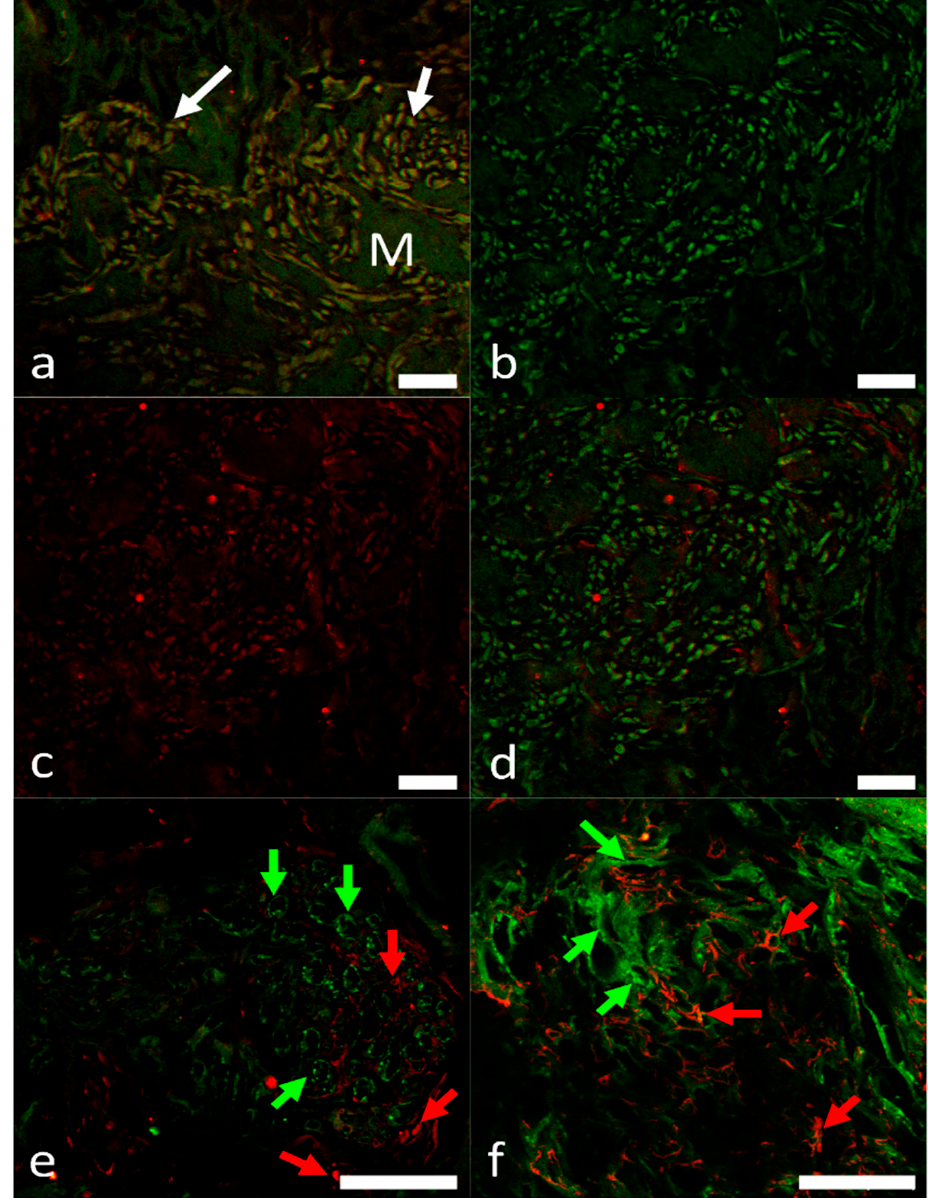
Figure 6. Multiple clusters of pacemaker cells detected by the double immunolabeling with antibodies against Islet-1 (green signal), and HCN1 and HCN2 (red signal) in the SAR. ( a ) Pacemaker cells (arrows) embedded in the myocardium (M) expressing Islet-1 (green signal) and HCN1 (red signal). ( b – f ) Pacemaker cells revealed colocalization of Islet-1 and HCN2 ( d ; merge). Two populations expressing Islet-1 (green signal and arrows) and HCN2 (red signal and arrows), respectively, were observed in e and f. Scale bars: 20 µ